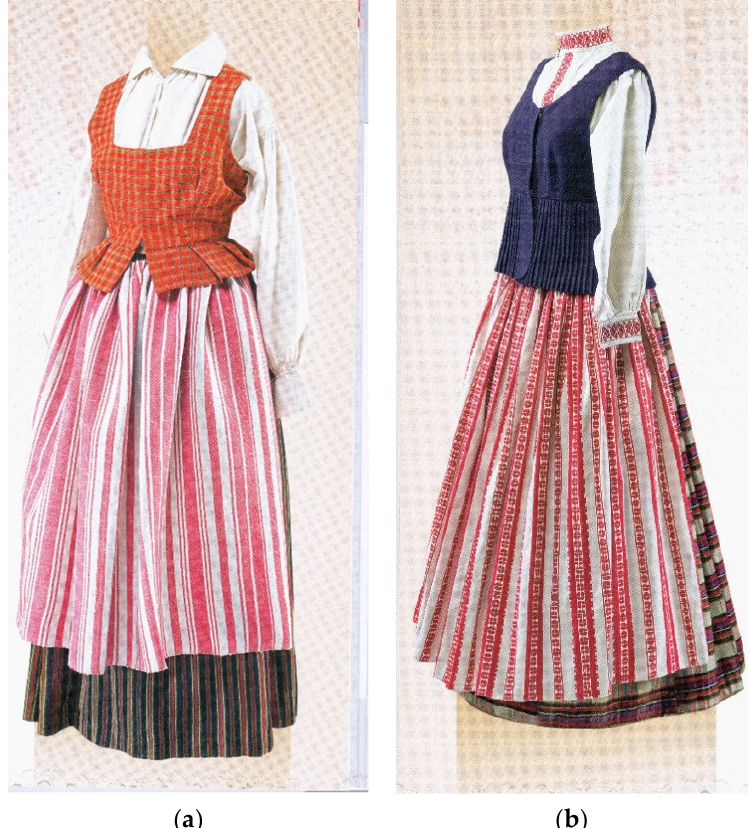
Figure 15. Folk costumes from Samogitia: ( a ) From Mažeikiai, Telšiai district, the 19th century: Skirt, A. and A. Tamošaitis gallery, Nr. 865; shirt LDM LA-1240; apron A. and A. Tamošaitis gallery, Nr. 903; vest LDM LA-2433; ( b ) from Raseiniai district, the 19th century: Skirt A. and A. Tamošaitis gallery, Nr. 858; shirt LDM LA-3019; apron A. and A. Tamošaitis gallery, Nr. 859; vest LDM LD-984/3. Women in Dz¯ukija wore motley folk clothes and checked skirts. The checking on these skirts was very diverse and smaller than that in Aukštaitija. Skirts also included raised threads to look more playful. In addition to checked skirts, horizontally striped skirts were also worn in Eastern Dz¯ukija, while vertically striped skirts were popular in the Lazdijai and Alytus districts. Summer skirts included small white and blue checks in the Prienai and Staklišk˙es districts, with a few bright stripes interwoven on the bottom. Half wool checked skirts of blue and white colours with highlights of brown, orange, and blue stripes were worn in the Kaišiadorys and Žiežmariai districts. These skirts are interesting because they feature weft woollen stripes woven with four harnesses. The variety of aprons was especially large. Some of them were horizontally striped with colourful stripes, other ones were checked or decorated on the bottom with overlaid ornaments. Skirts that were white, hemstitched, or featured interweaves of other colours of thread on the bottom were worn in the North-Eastern area; these skirts were decorated with wide lace around Jieznas. Linen white shawls—sheets—worn in the summer were decorated with similar interweaves and lace in those districts. Aprons with a dark background and embroidered with flowers in bright colours at the bottom were especially popular from the end of the 19th century to the first half of the 20th century. Vests with rectangular pads in the front were the most popular. Vests pierced and pleated from the torso were worn in the Vilnius, Trakai, and Vievis districts. Vests that were short, just to the waist, were also worn. Shirts were decorated in different ways. The cuts and decorations of South-Western Dz¯ukija shirts worn with white thread in perforated patterns along with filling embroidery were close to those of Suvalkija shirts (wider sleeves and more embroidery).